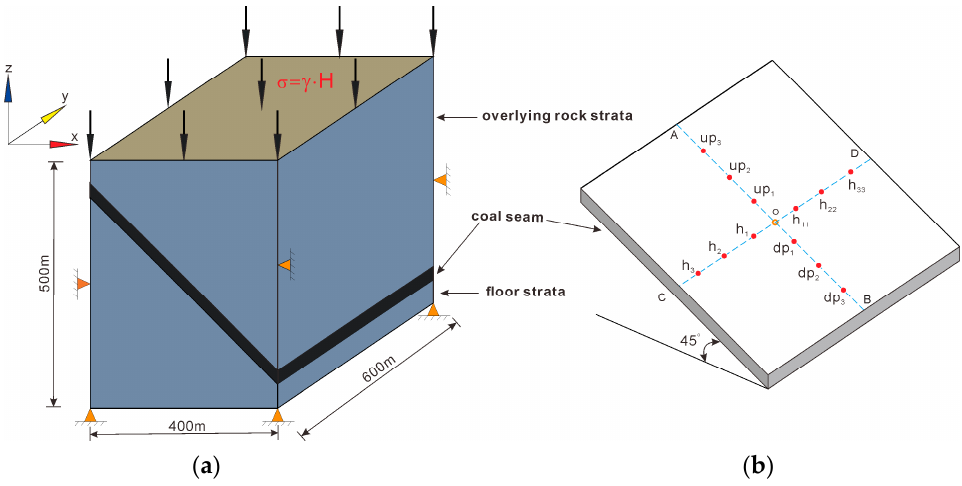
Figure 3. Numerical simulation model, ( a ) simplified geological model, ( b ) model of the coal seam.